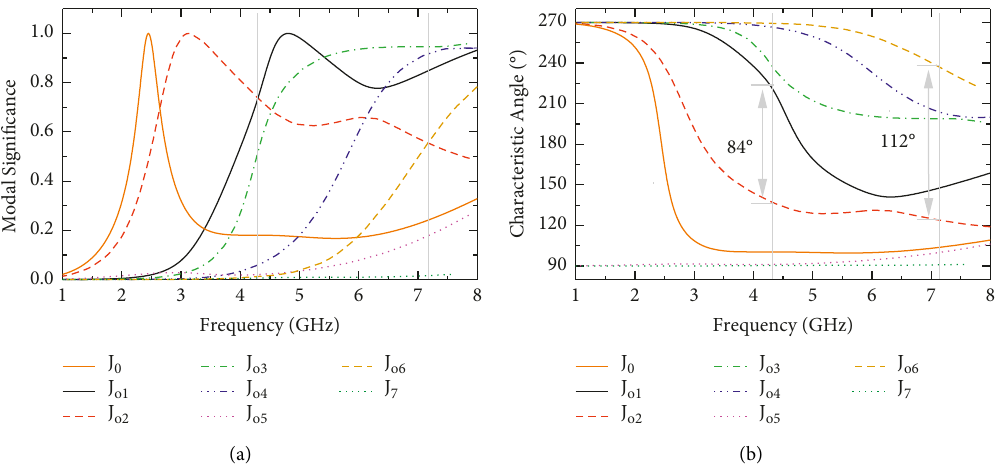
Figure 7: (a) Modal significance and (b) Characteristic angle for the first eight modes of Proto A calculated at 4 GHz.